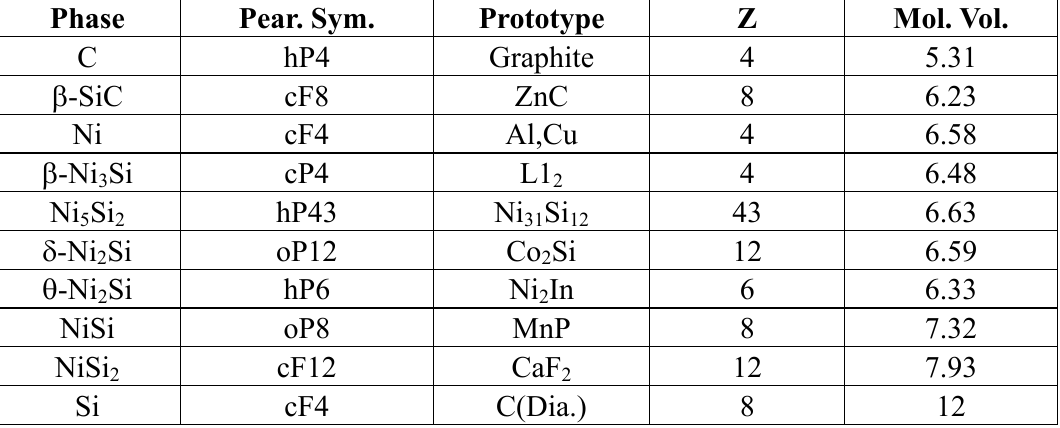
Table 1. The crystallographic data and molar volumes of Si-C-Ni system